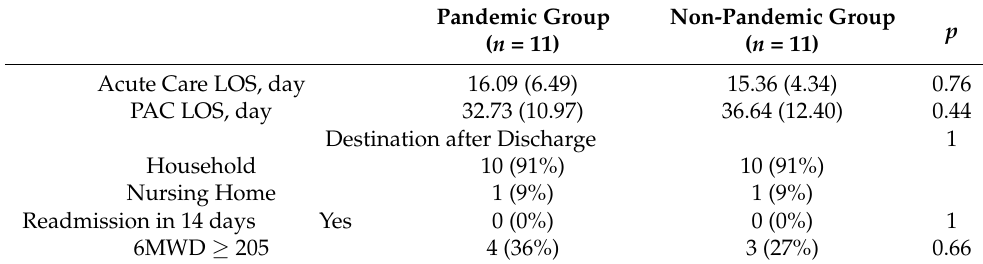
Table 5. Quality of medical care in both